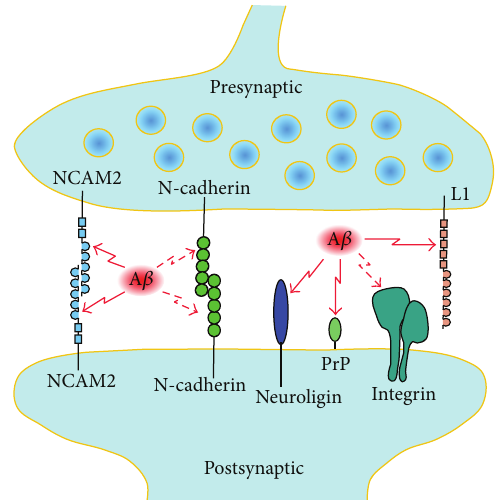
Figure 3: Synaptic CAMs function as receptors for A 𝛽 . Schematic representation of a synapse showing presynaptic and postsynaptic CAMs, which bind to A 𝛽 . Direct interaction with A 𝛽 has been demonstrated for NCAM2, neuroligin, PrP c , and L1 (solid red arrows). Binding of A 𝛽 to integrins and N-cadherins is suggested by indirect observations and remains to be confirmed in a direct binding assay (dashed red